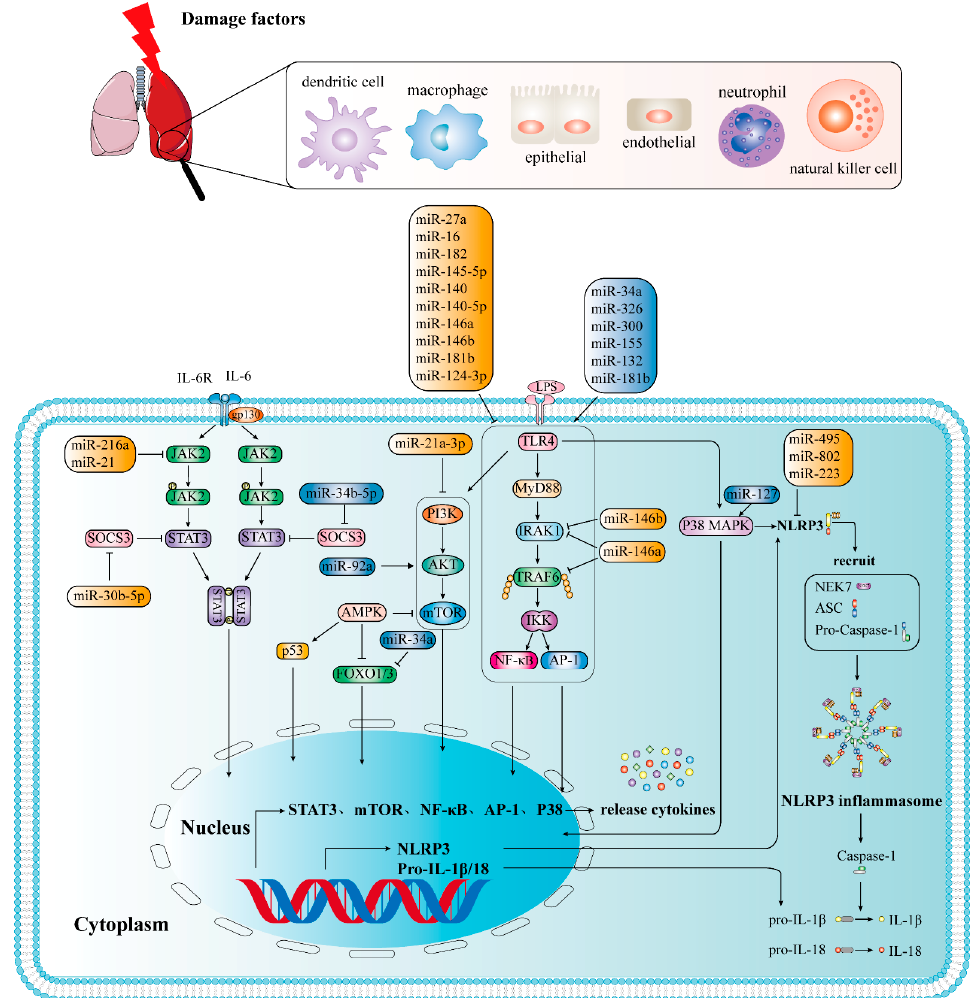
Figure 3. The role of microRNAs in LPS-induced